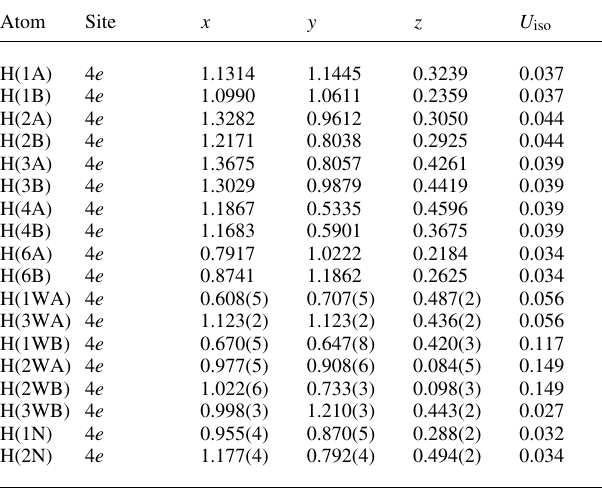
Table 2. Atomic coordinates and displacement parameters (in Å 2 )